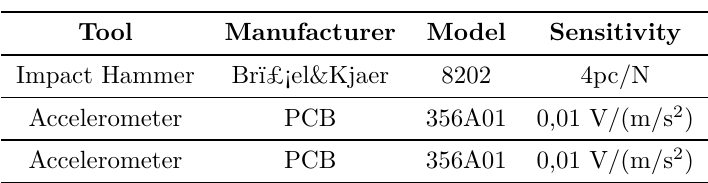
Table 1. List of experimental